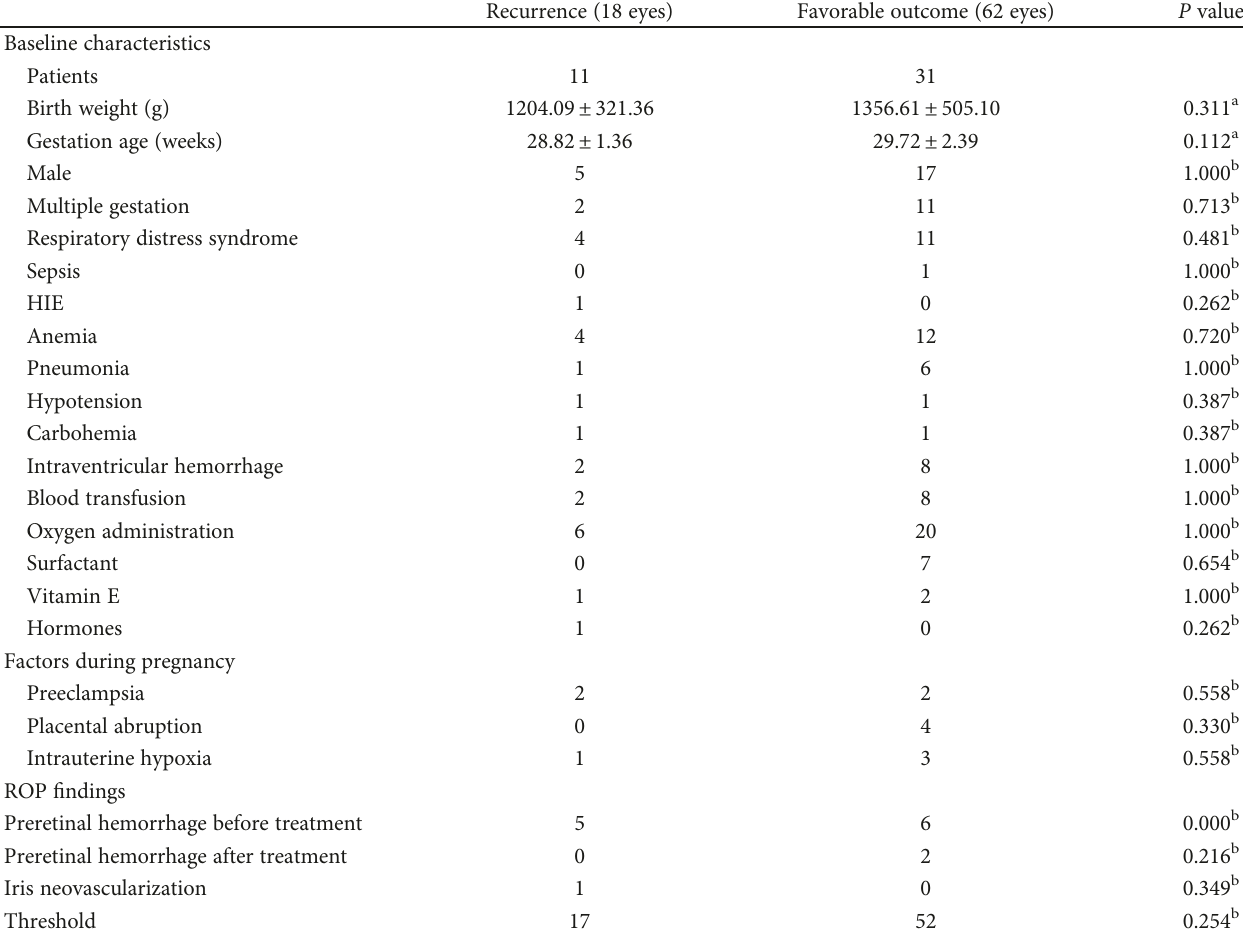
Table 1: Univariate analysis of baseline demographics and recurrence in the eyes with retinopathy of prematurity in Zone II Stage 3 after ranibizumab